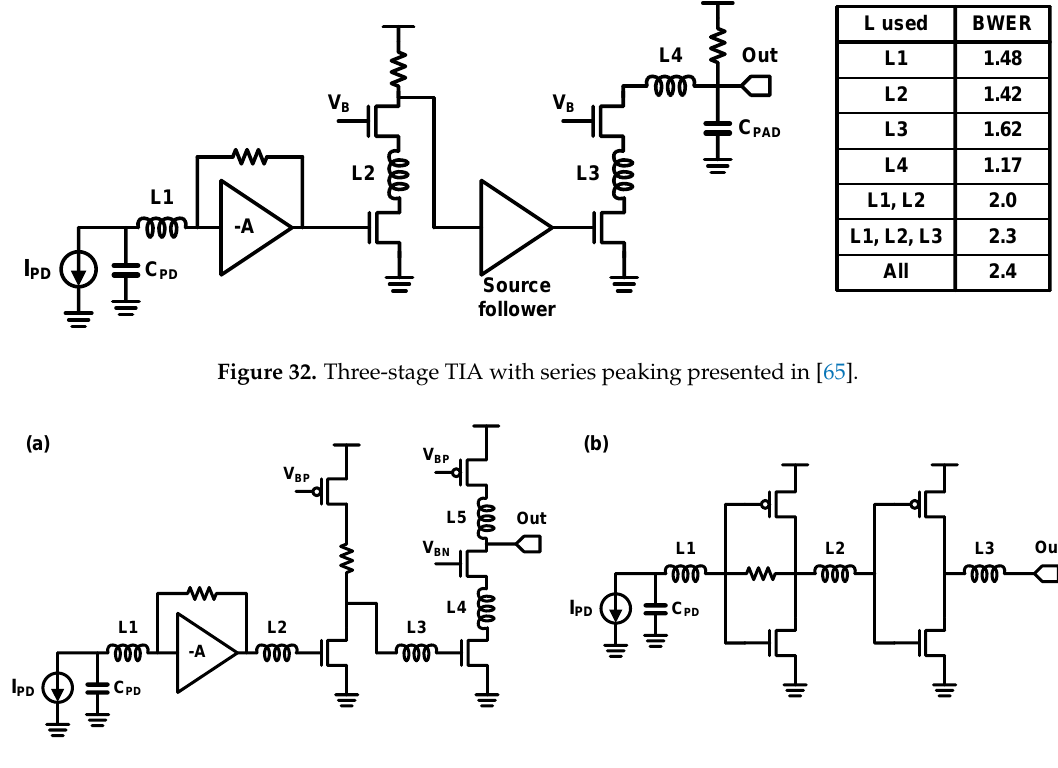
Figure 33. TIA examples with series peaking between cascaded gain stages presented in ( a ) [61] and ( b ) [71].